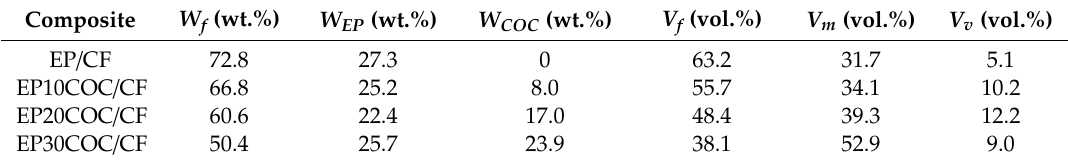
Table 1. Results of TGA tests on EP-CF and EPxCOC/CF laminates (x = 10–30 wt.%).